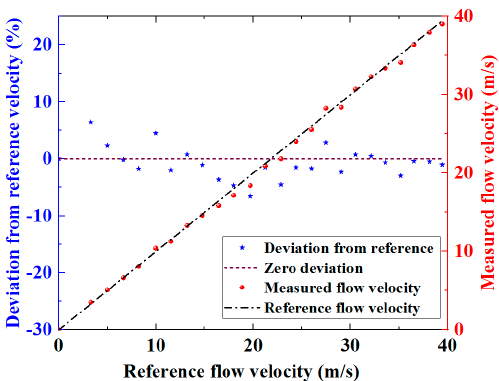
Figure 10. Measured flow velocity as a function of the reference velocity, with associated deviation data, extracted from the spatial averaging method for eight individual ultrasonic paths.